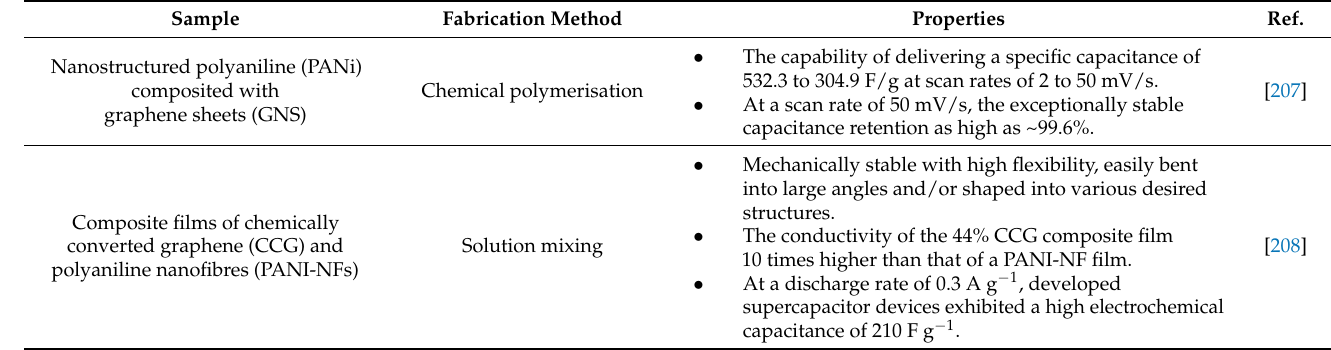
Table 3. Fabrication and properties of graphene-based materials used energy storage and energy conversion devices.